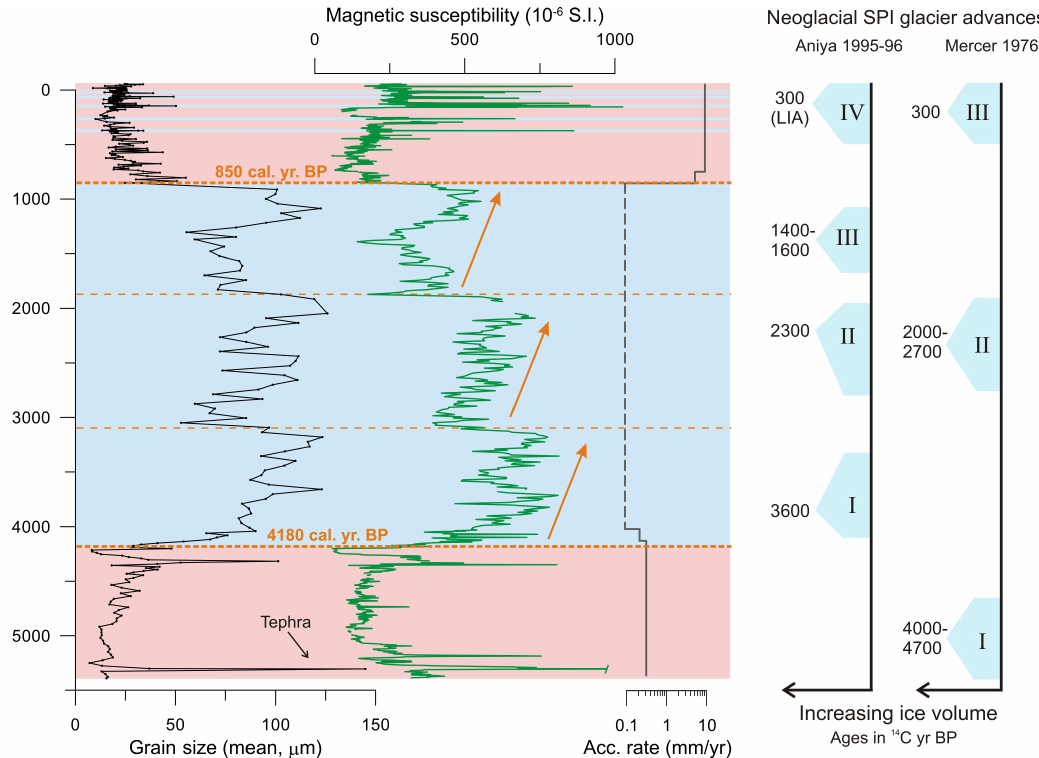
Fig. 8. Mean grain size, magnetic susceptibility and average accumulation rates of sediment core JPC14 plotted against age. The colors in the background represent the interpretation of the proxy variations (blue: glacier advance, pink: glacier retreat). The Mercer and Aniya- type chronologies of Neoglacial advances of SPI glaciers are indicated for comparison (Mercer, 1976, 1982; Aniya, 1995, 1996). The accumulation rate between 4020 and 850calyrBP is represented by a dashed line to indicate possible changes in accumulation rates not identified in our age-model. The representation of the SPI glacier fluctuations was inspired by the Fig. 4 of Glasser et al.